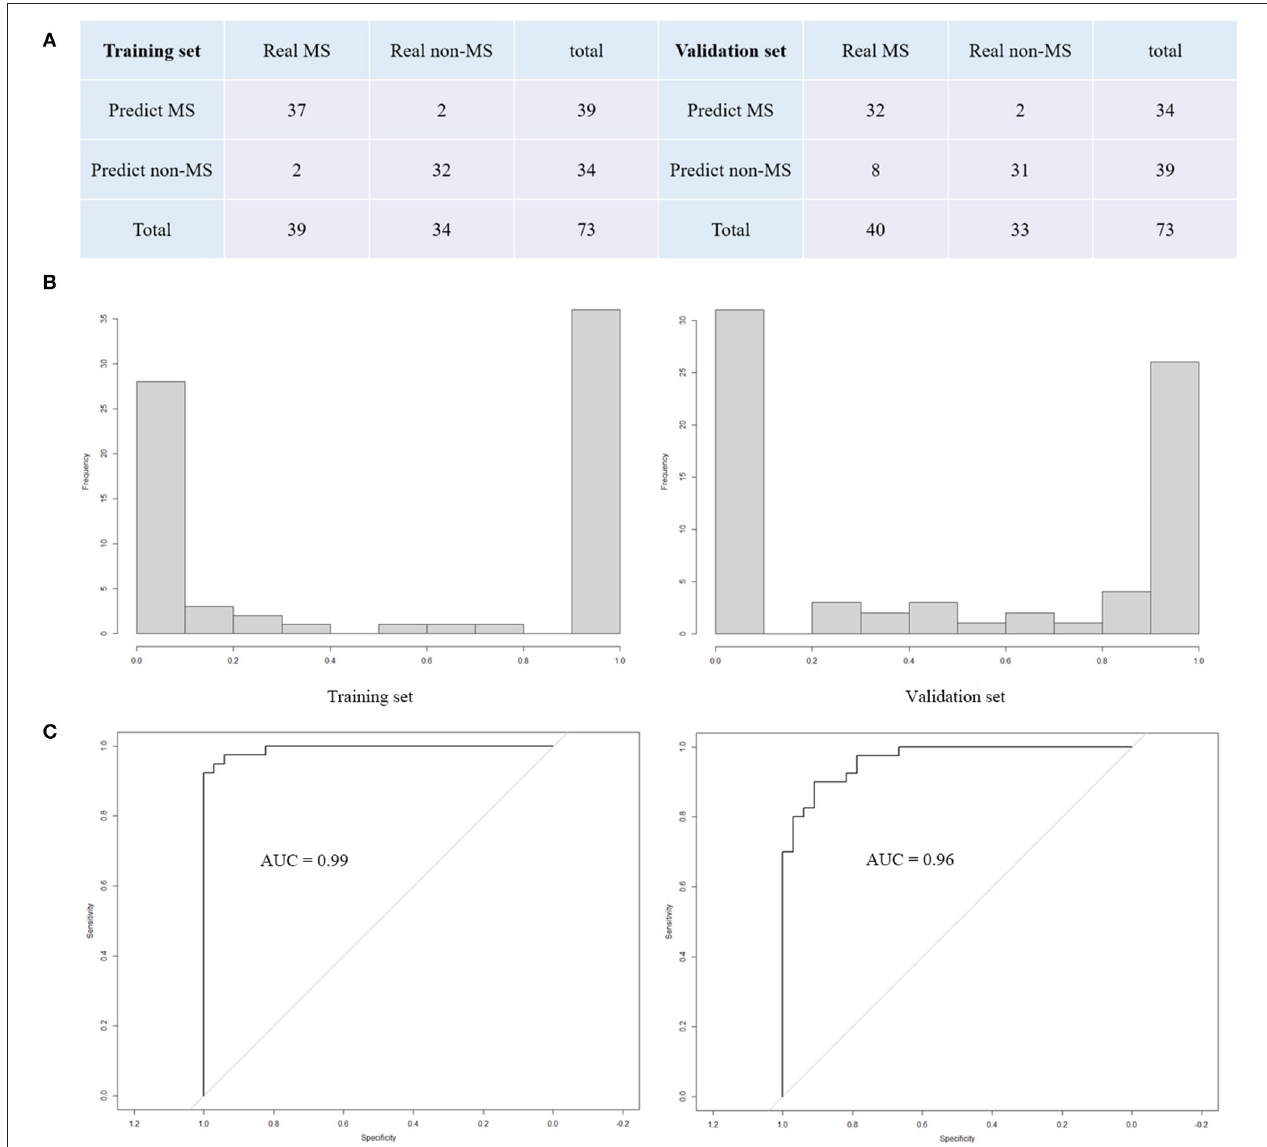
FIGURE 5 | (A) The confusion matrix of the prediction model. (B) The histogram of the output predicted probability, and it can be seen that the distribution of the predicted probability is concentrated at both ends. (C) The receiver operating characteristic curve (ROC). AUC is the size of the area under ROC.